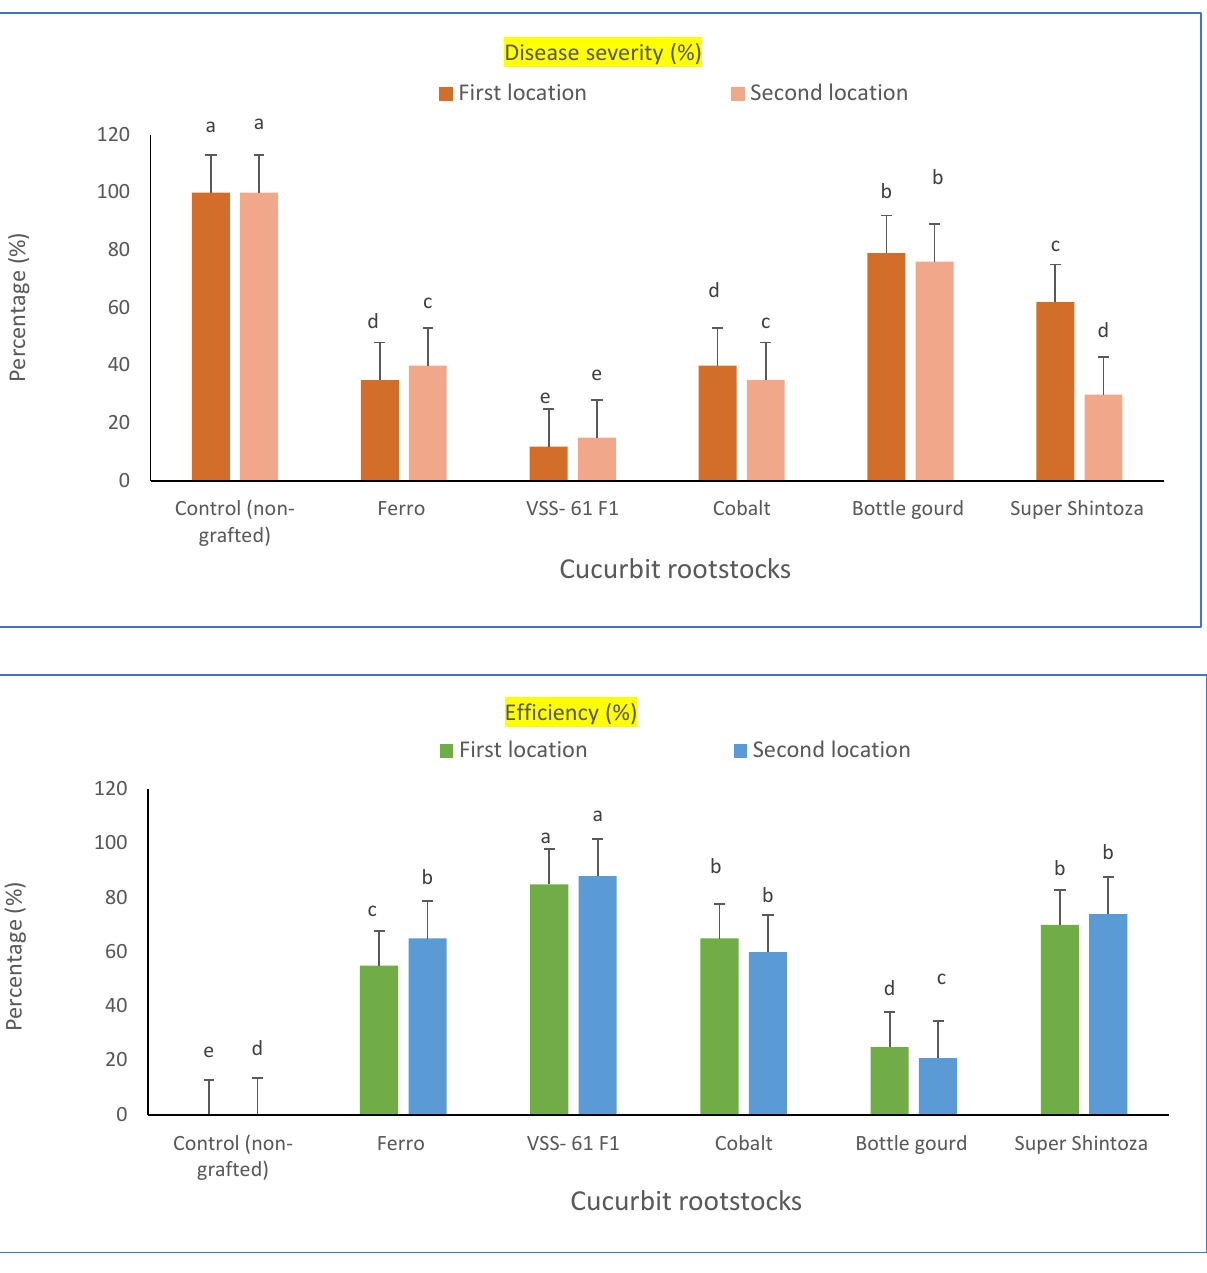
Figure 1. Fusarium wilt disease severity percentage and efficiency percent of greenhouse cucumber plants grafted on different rootstocks under disease pressure and heat stress in both locations. Values are means ± standard deviation (SD) from three replicates. Different letters in the same column show significant differences among each group of treatments according to Duncan’s test at p ≤ 0.05.